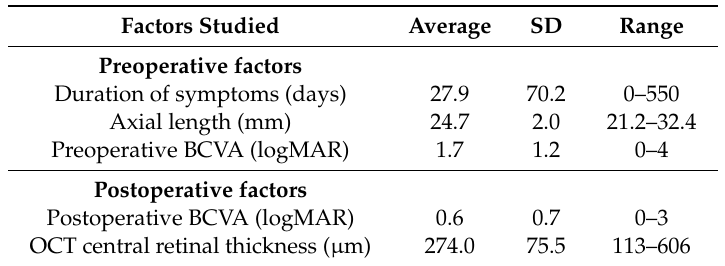
Table 3. Numerical variables of patients included in the study.